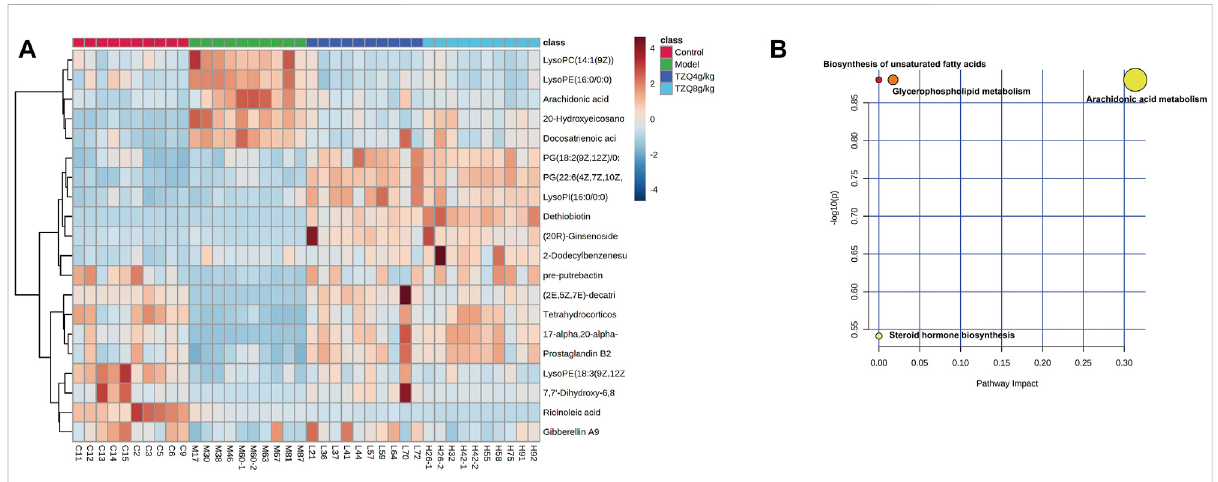
FIGURE 7 Metabolic biomarkers and metabolic pathway screening of TZQ in the treatment of AS. N = 10 mice for each group. (A) : Heatmap of potential biomarkers for the treatment of AS with TZQ. (B) : Metabolic pathway analysis.